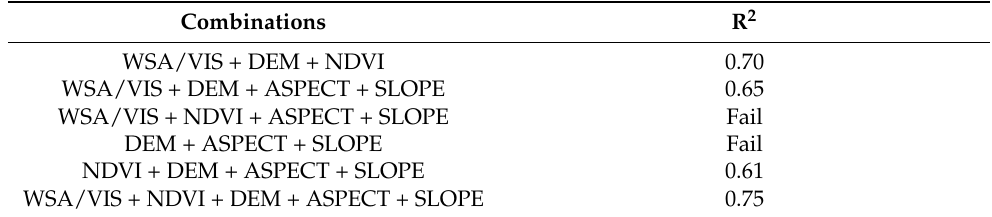
Table 4. R 2 results from combinations of many parameters for one night obtained from MOD11A1 over SFP on 10 October 2019.